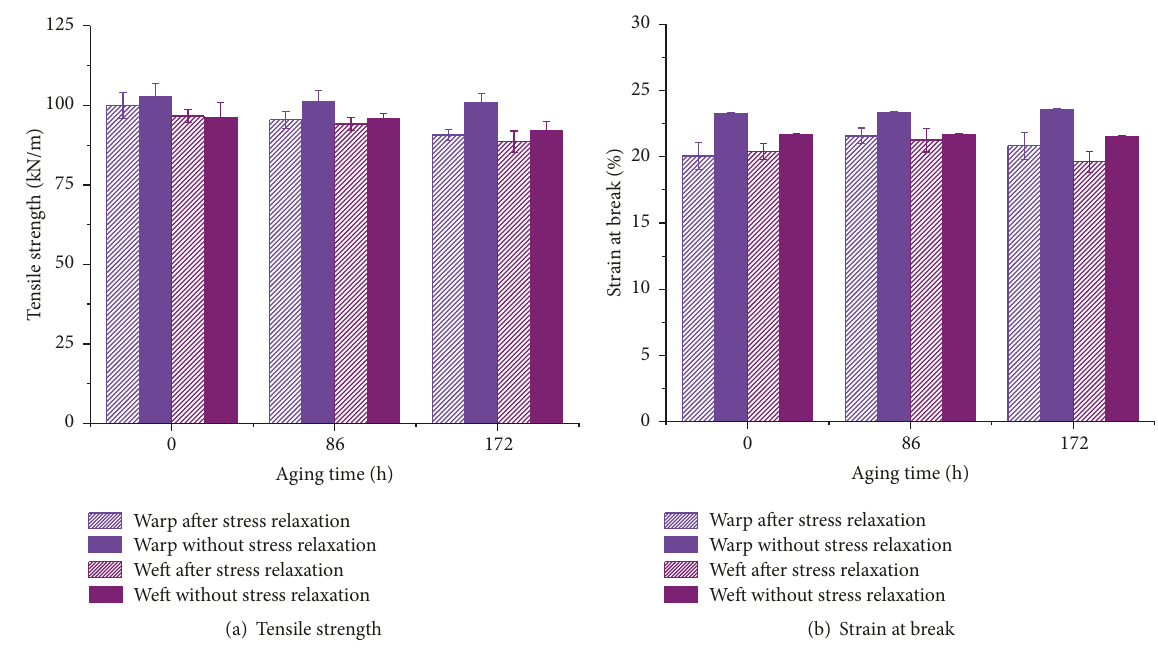
Figure 10: Tensile properties of materials (after stress relaxation) after